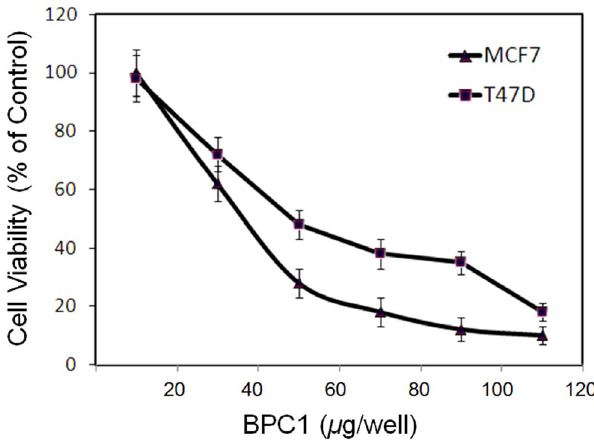
Figure 2. Dose - dependent growth inhibitory effect of BP-C1 on MCF-7, T47D cells. Exponentially growing cells were incubated in the absence or presence of 100 to 1,000 m g/ml BP-C1 for 48 hours and the viable cells were counted as described under Materials and Methods. The results are presented as percentage of control and expressed as means 6 standard deviation of three independent experiments in which each treatment was performed in triplicates.